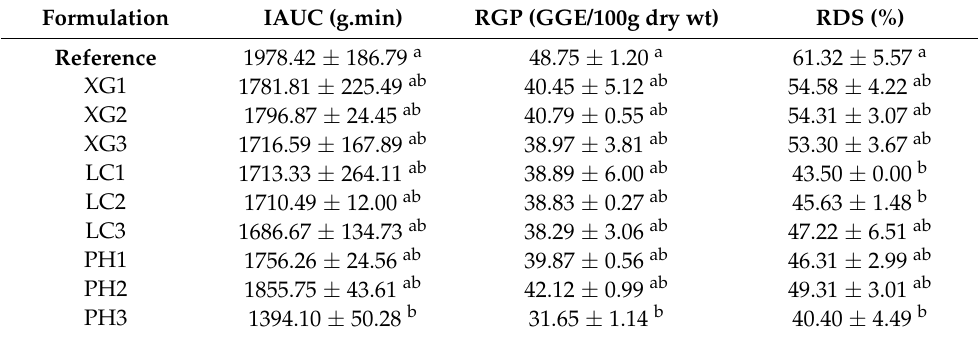
Table 3. Estimated GI values and categories of bread formulations based on a dry weight basis. Formulation